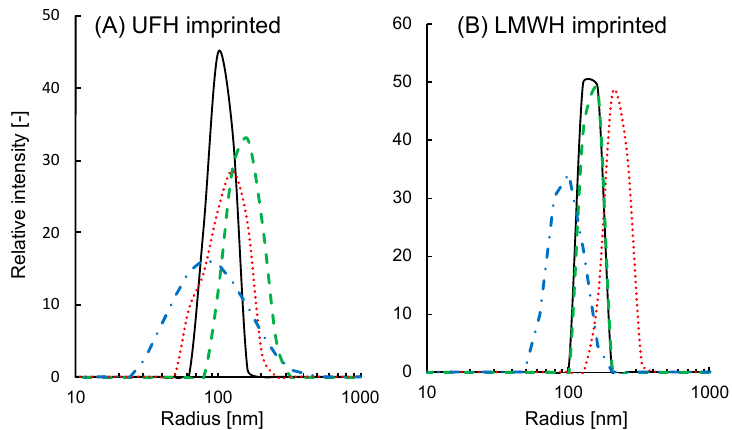
Figure 1. A comparison of the radius distributions of ( A ) the polymer nanoparticles imprinted by unfractionaled heparin (UFH-MIP-NP) and ( B ) those imprinted with low molecular weight heparin (LMWH-MIP-NP) in the absence of glycosaminoglycan (black solid lines) and in the presence of UFH (green dashed lines), LMWH (red dotted lines) or chondroitin sulfate C (CSC) (blue dot-dashed lines). The concentration of the glycosaminoglycan is 1 units/mL with UFH-MIP-NP and 5 units/mL with LMWH-imprinted nanoparticles.